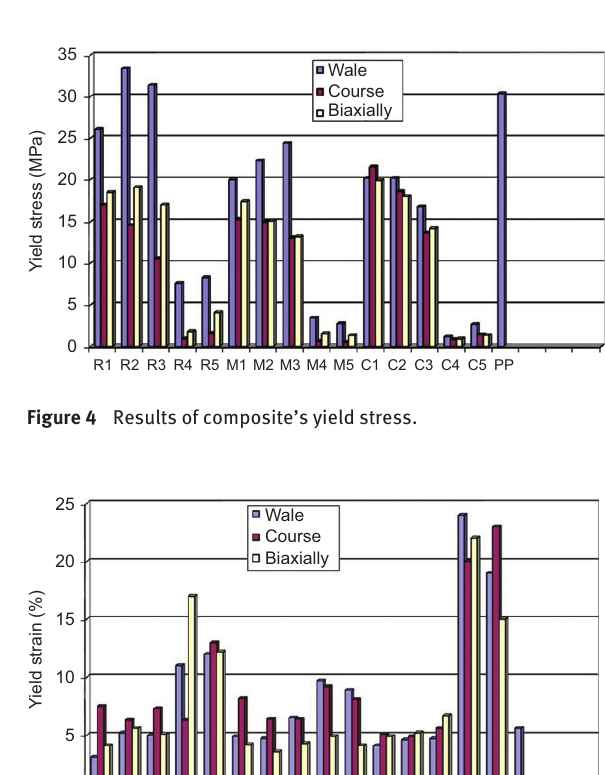
Figure 6 Results of composite ’ s maximum stress.